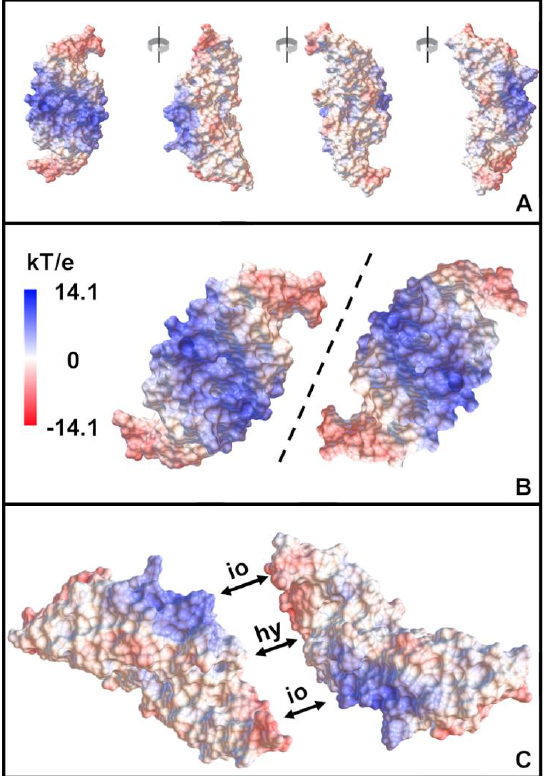
Figure 3. Electrostatic surface potential of BMP-2 at pH 5 as determined by continuum electrostatic calculations. ( A ): BMP-2 displayed from all sides and ( B ): view on the central cavities of two BMP-2 molecules showing the possible interaction patches frontally. The dotted line indicates the axis at which negatively charged (red) areas are reflected in complementary positively charged (blue) areas and at which hydrophobic (white) areas are reflected in other hydrophobic areas. ( C ): Possible interaction patches facing each other. Compared to ( B ), the two BMP-2 dimers were rotated 90° towards each other. io = possible electrostatic attraction, hy = possible hydrophobic interaction.